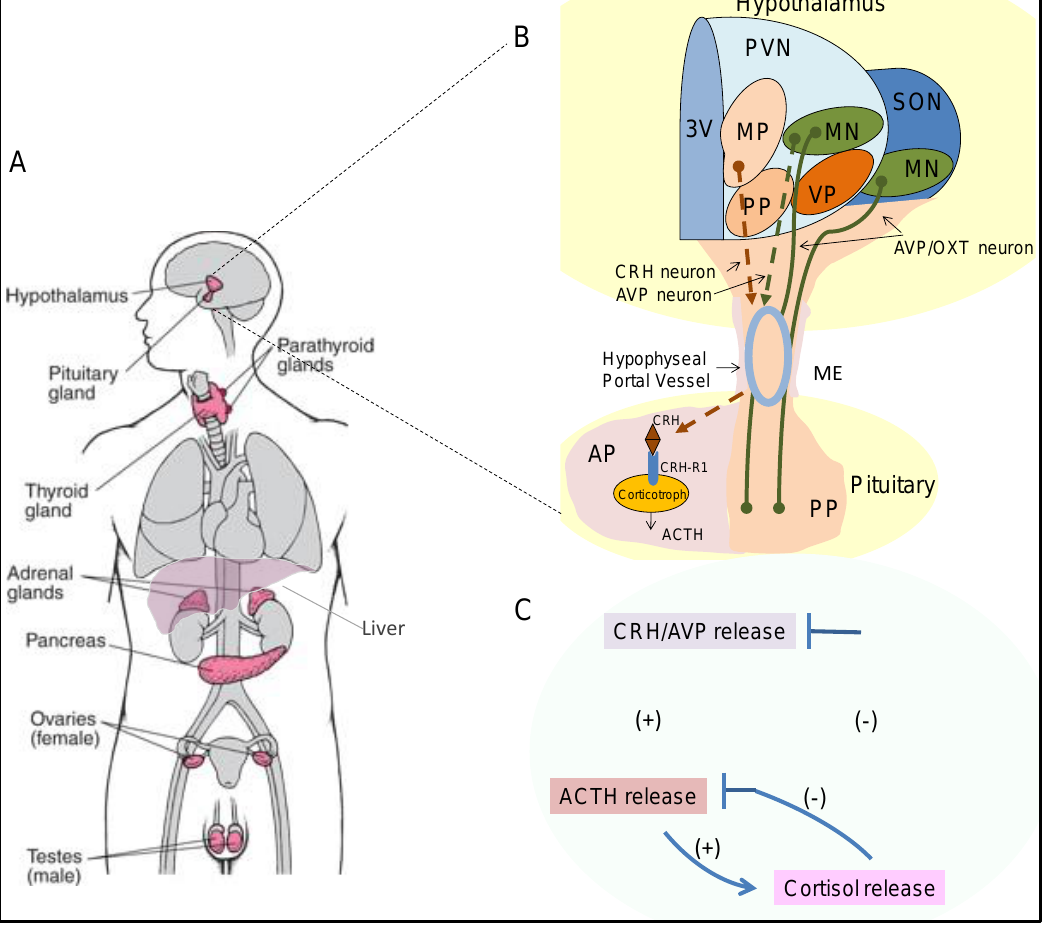
Figure 1. Schematic diagram of the hypothalamic-pituitary-adrenal (HPA) axis. ( A ) The major glands of the endocrine system include the hypothalamus and pituitary gland centrally and the thyroid, islet cells of the pancreas, adrenal glands, liver and gonads peripherally. ( B ) The HPA axis is regulated by hypothalamic corticotropin-releasing hormone (CRH) and arginine vasopressin (AVP), which are produced in the paraventricular nucleus (PVN) of the hypothalamus and transported to the anterior pituitary, where they drive synthesize and secretion of pituitary adrenocorticotropic hormone (ACTH). In the adrenal cortex, ACTH stimulates the adrenal zona fasciculata cortex to release glucocorticoids (GCs), which have numerous physiological effects. ( C ) GCs also exert negative feedback at the level of the hypothalamus and pituitary to dampen excessive activation of the HPA axis. 3V, the third ventricle; AP, anterior pituitary; ME, median eminence; MP, medial parvocellular; MN, magnocellular nucleus; OXT, oxytocin; PP, periventricular parvocellular; SON, supraoptic nucleus; VP, ventral parvocellular.